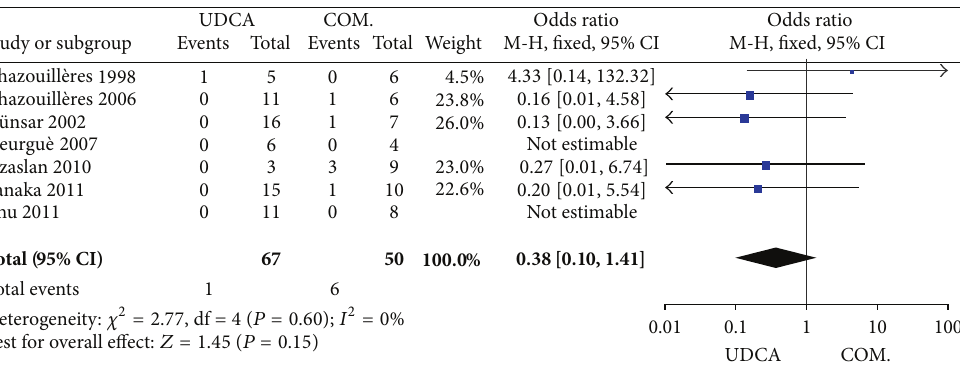
Figure 7: Death or liver transplantation in patients treated with monotherapy versus combination therapy for